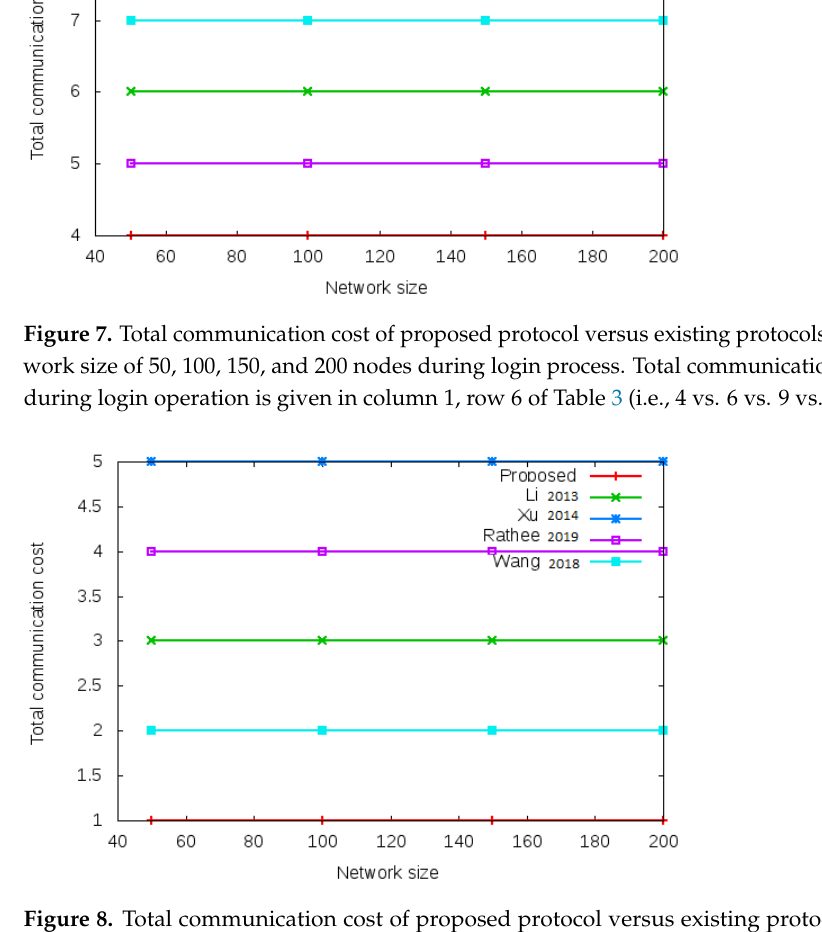
Figure 8. Total communication cost of proposed protocol versus existing protocols with different network size of 50, 100, 150, and 200 nodes during handover process. Total communication cost comparison during handover operation is given in column 1, row 6 of Table 4 (i.e., 1 vs. 3 vs. 5 vs. 4 vs.